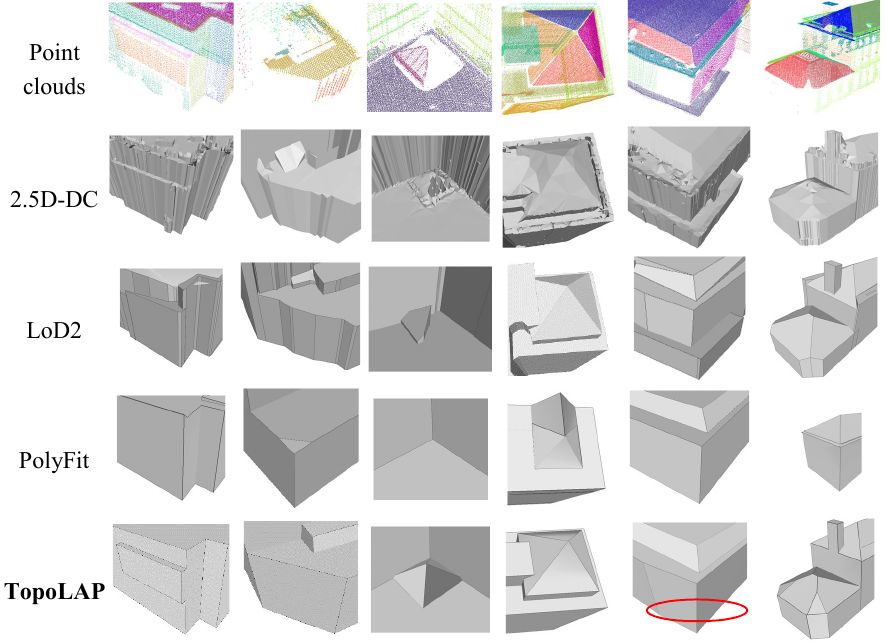
Figure 14. Comparative results of selected details.